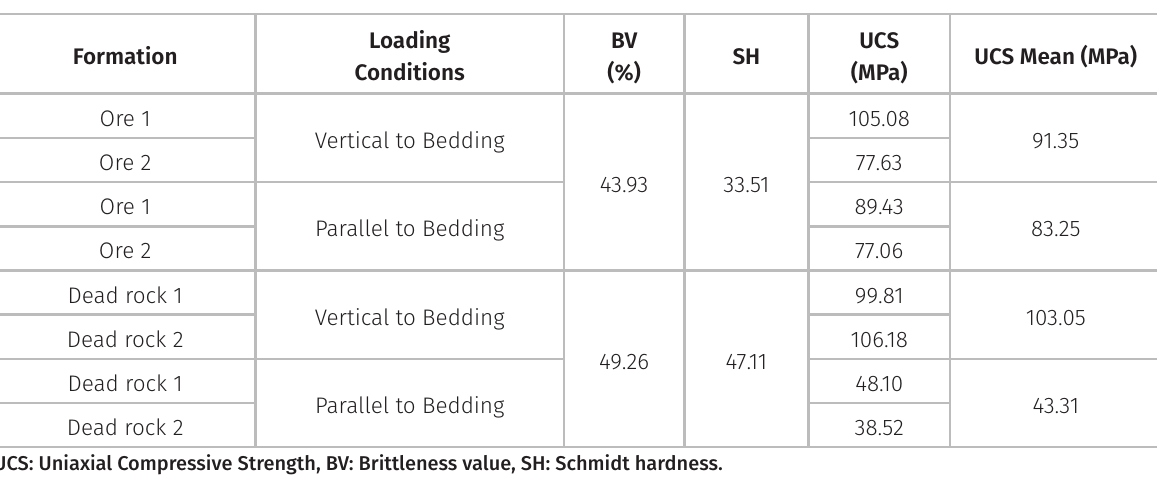
Table III. Physical properties of ore and dead rock in different bedding direction.